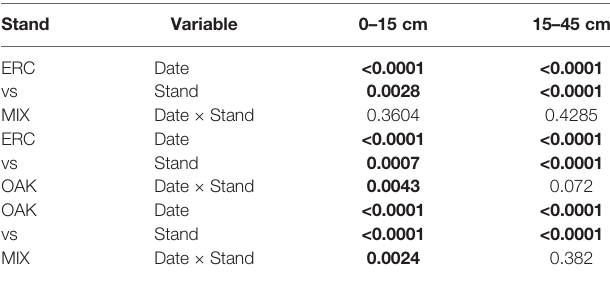
TABLE 2 | Results of PROC MIXED model with repeated measurements and autoregressive covariance structure for effects of date, stand, and their interaction on soil water content ( q ) in 0 – 15 and 15 – 45 cm depth. Bold text indicates signi fi cance p < 0.05. Stand Variable 0 – 15 cm 15 – 45 cm